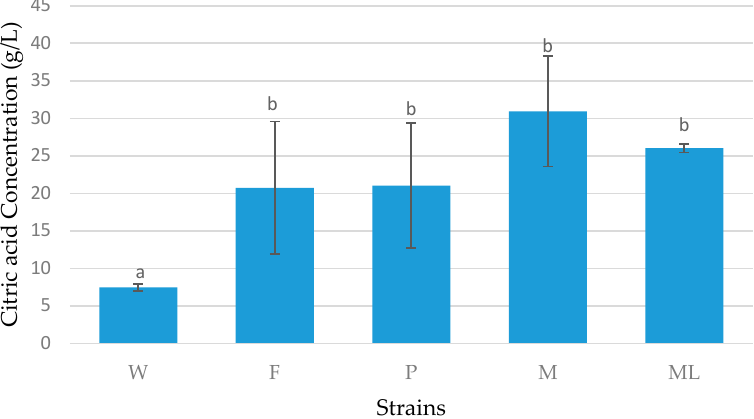
Figure 2. Study of 6-day shake flask cultures for citric acid production by the H, F, P, M and ML strains/treatment. Glycerol based media under nitrogen-limiting conditions (C/N = 50). Error bars represent a standard deviation for n = 3. W: H222 wild type strain, F: ∆ POX1 -6 ∆ LEU2 ∆ SNF1 ∆ FAA1 ∆ SNF1::URA3 , P: F + ∆ LEU2:: URA3 YlALK5 YlCPR YlFAO1 , M: P + YlALK5:: URA3 , ML: M + 400 mg/L leucine. ab Columns with dissimilar letters at the top are significantly different ( p < 0.05).